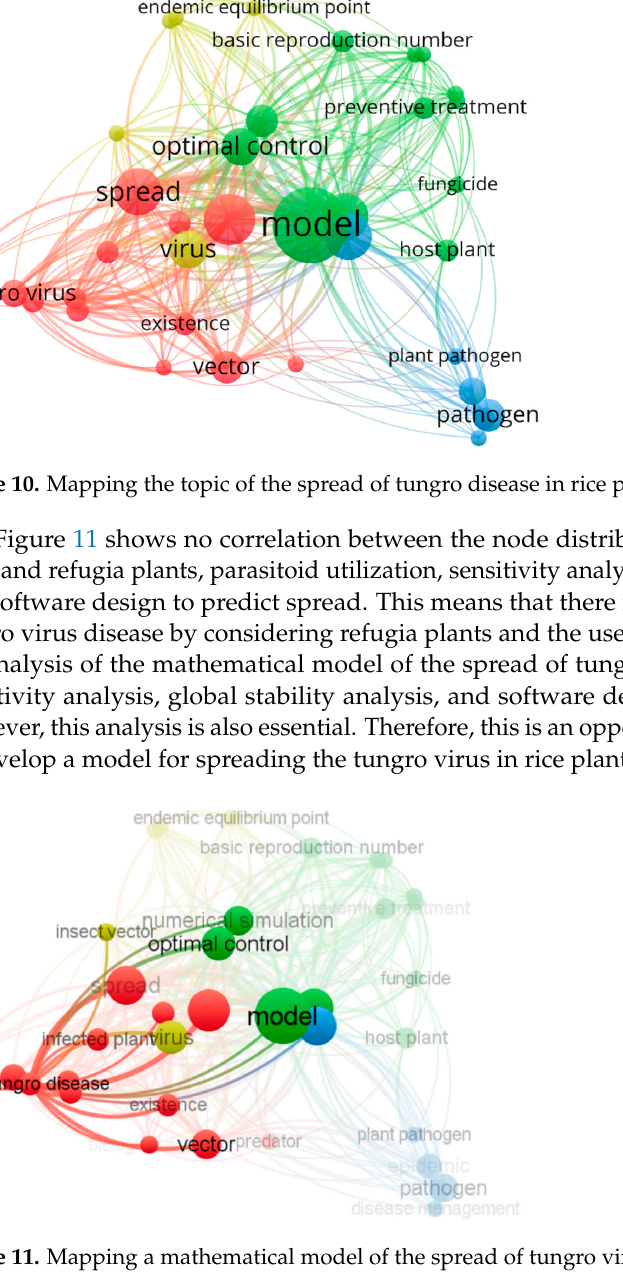
Figure 11. Mapping a mathematical model of the spread of tungro virus in rice plants.